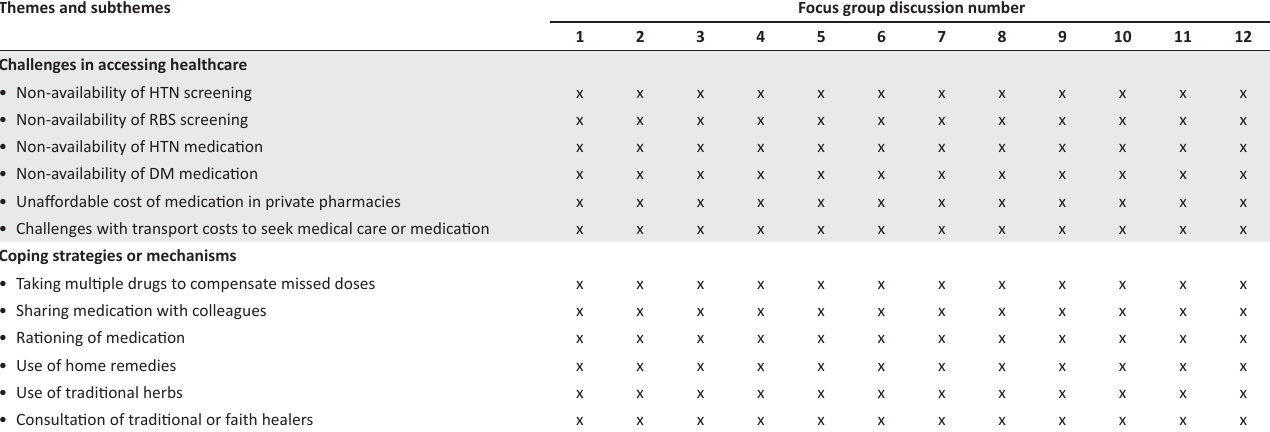
TABLE 4: Saturation grid of themes and subthemes emerging from focus group discussions. Themes and